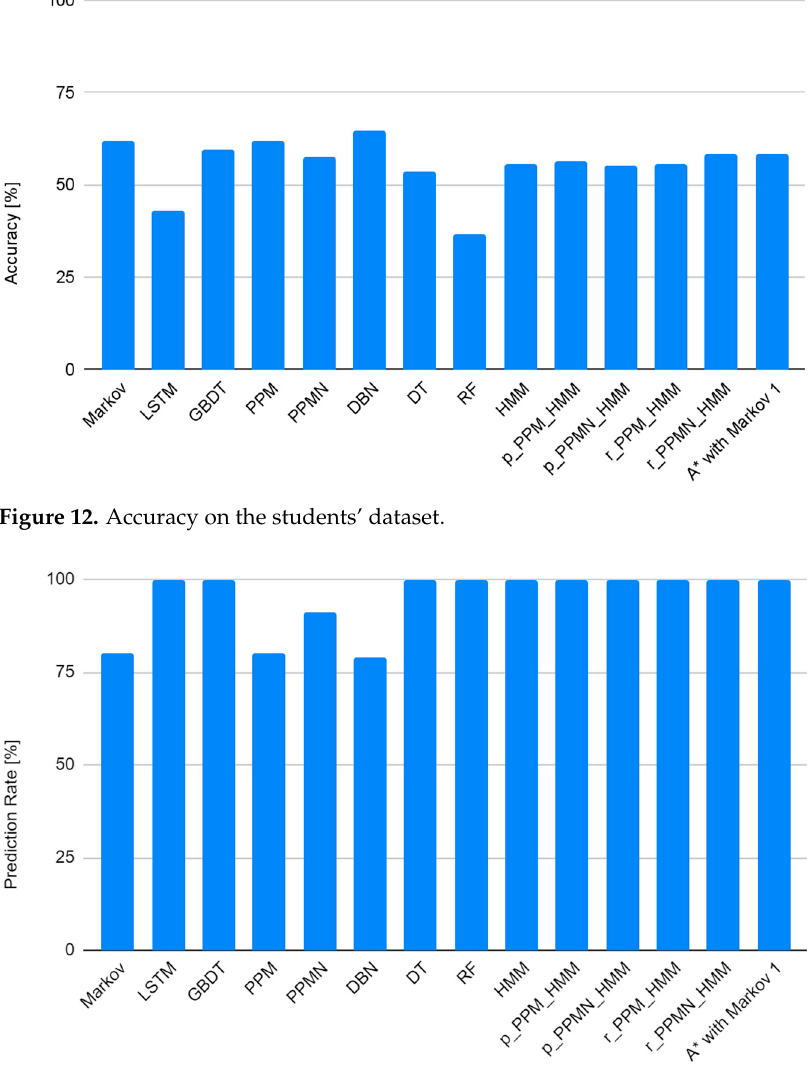
Figure 13. Prediction rate on the workers’ dataset.